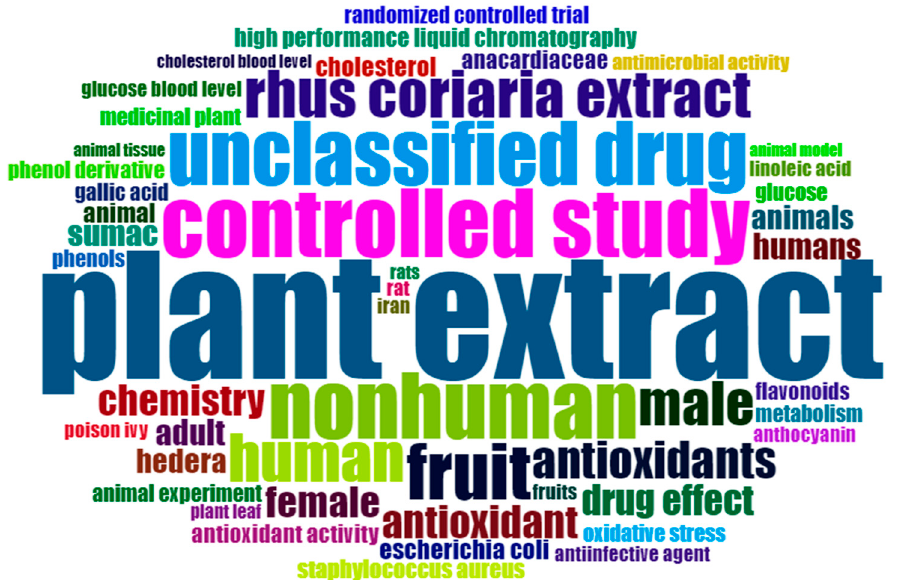
Figure 3. Wordcloud generated from the “keyword plus” (n = 1836) of the 183 selected documents according to the frequency of word occurrence. Keywords such as “sumac”, “rhus”, and “article” were omitted as too generic. “Plant extract” and “plant extracts” were considered synonymous. The illustration was created with the wordcloud2 package in R.